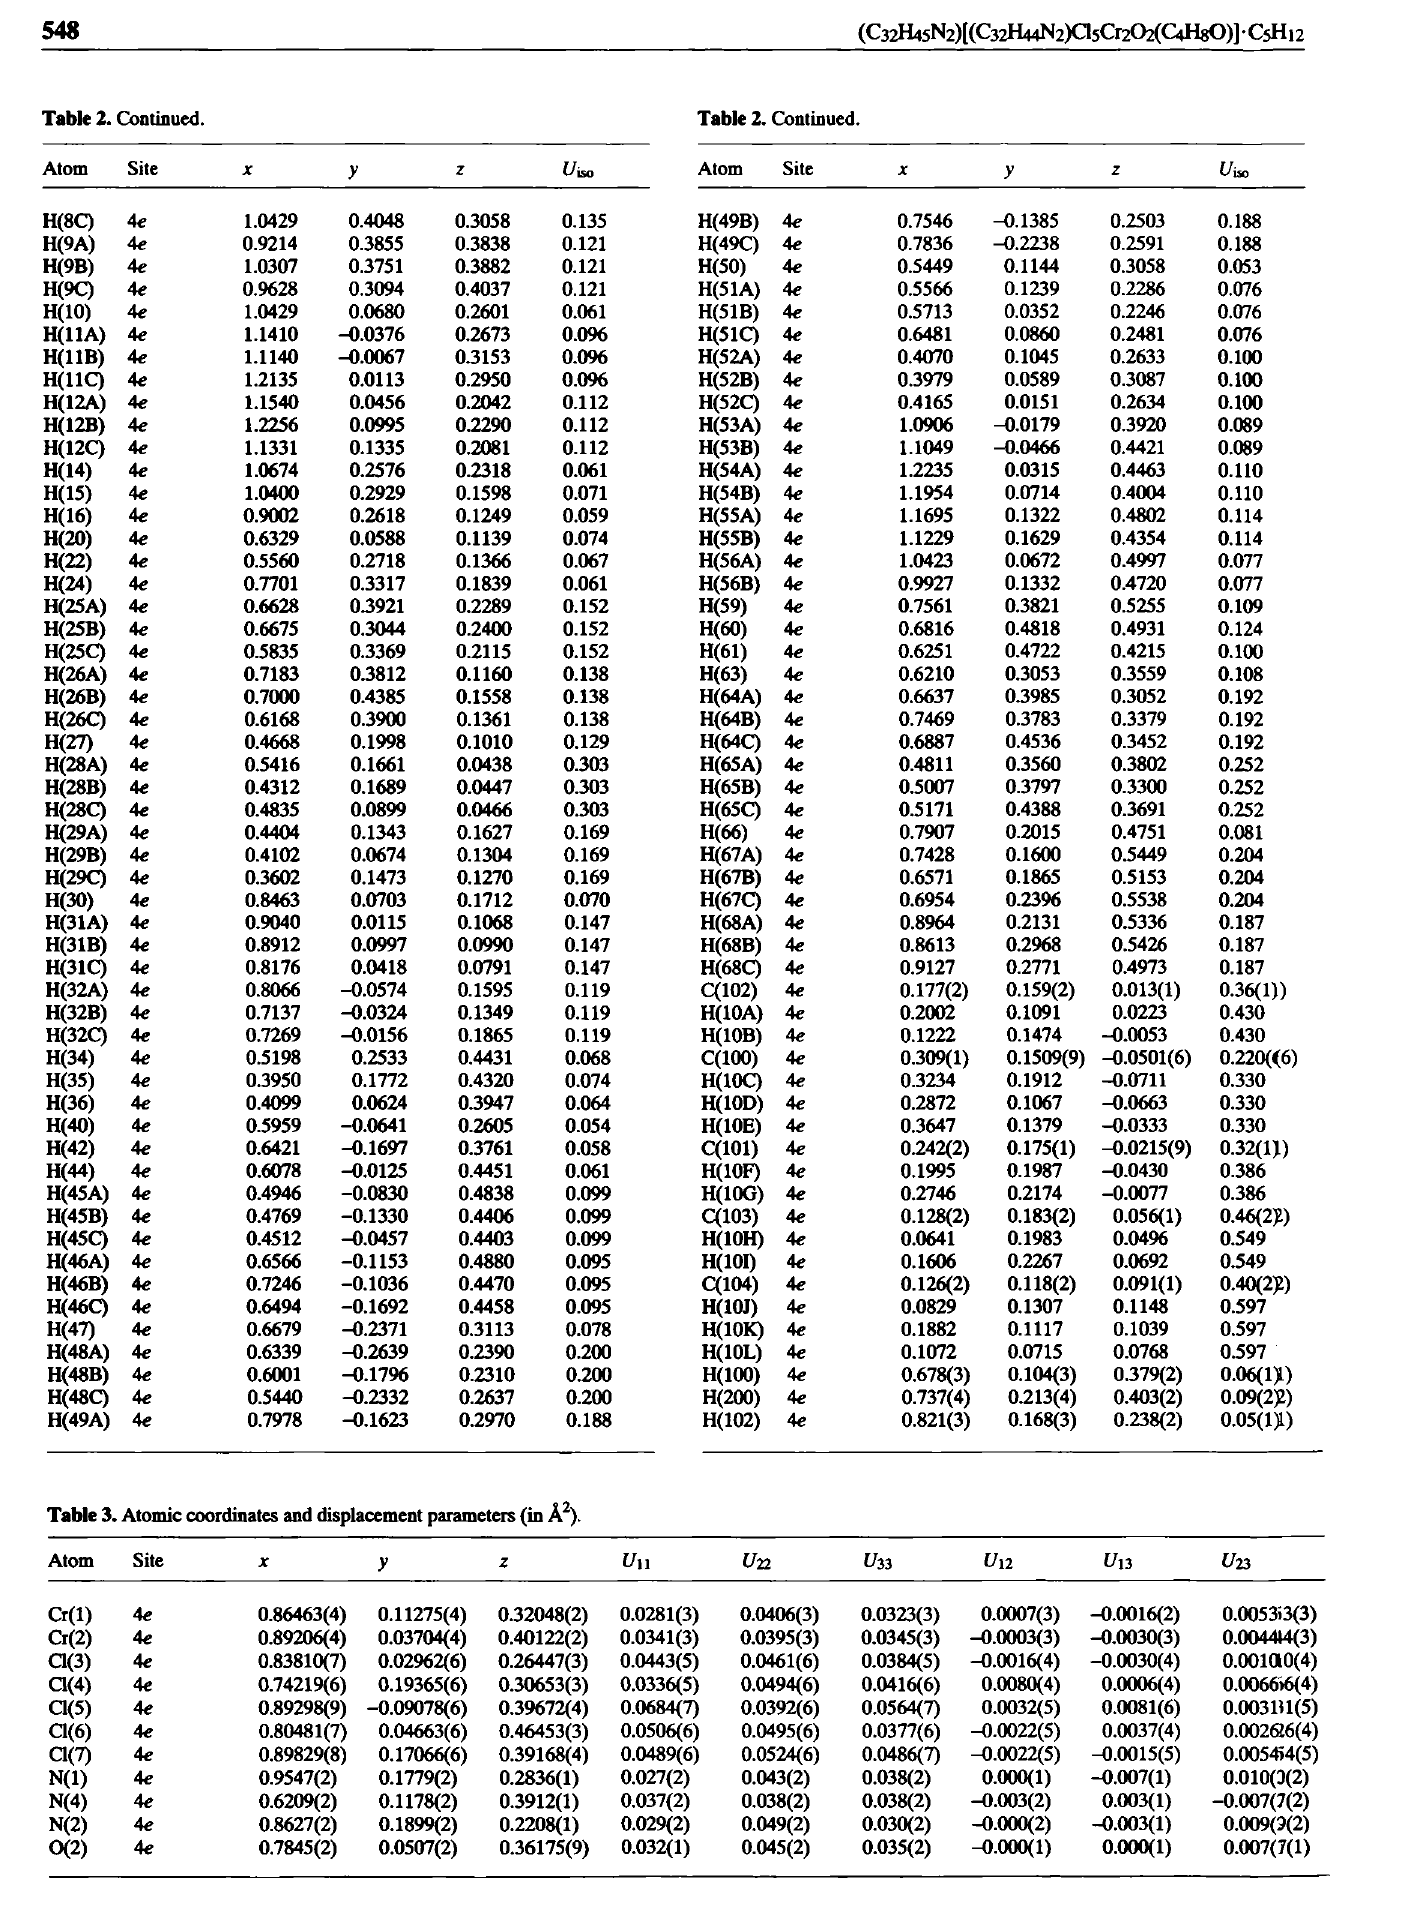
Table 3. Atomic coordinates and displacement parameters (in Ä 2